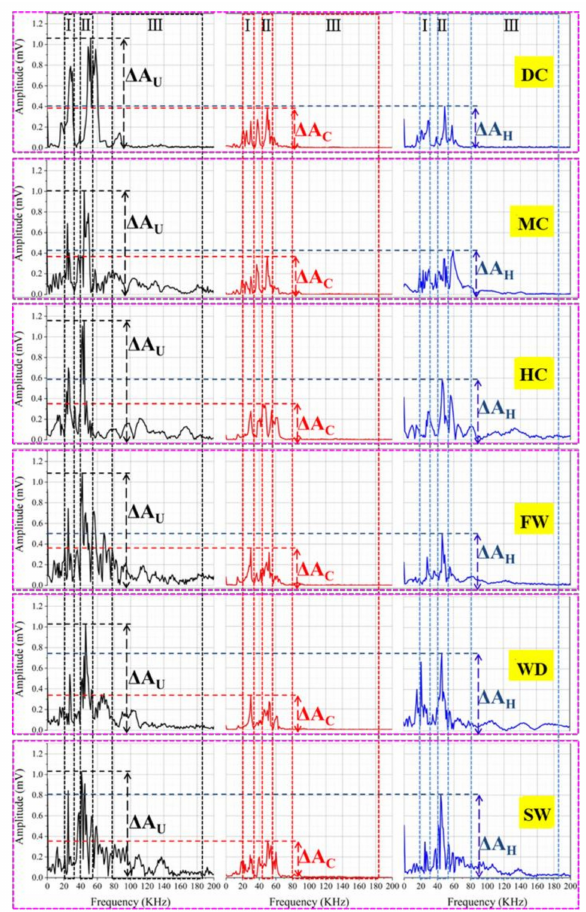
Figure 12. Frequency of ultrasonic waves for the samples with different states: the black, red, and blue lines belong to the uncracked, cracked, and sealed samples, respectively.